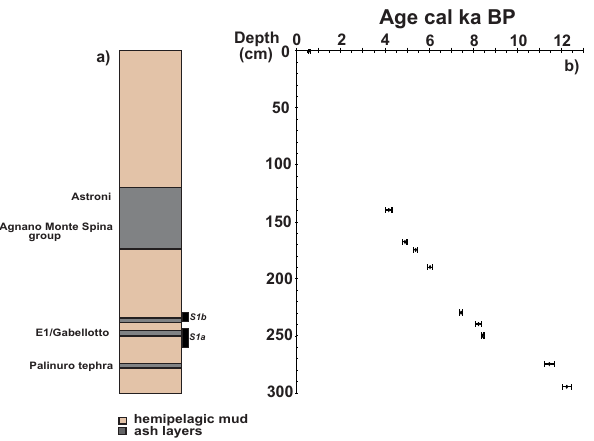
Fig. 2. (a) Lithology as a function of depth of the core MD90-917. S1a and S1b refer to the two-step sapropel units. Gray lines mark tephra layers recovered along the core and their origin. (b) Age– depth relation for core MD90-917 based on 10 linearly interpolated 14 C AMS dates. 14 C ages are shown in calendar ka BP including a reservoir 14 C age correction as indicated in Siani et al. (2000,